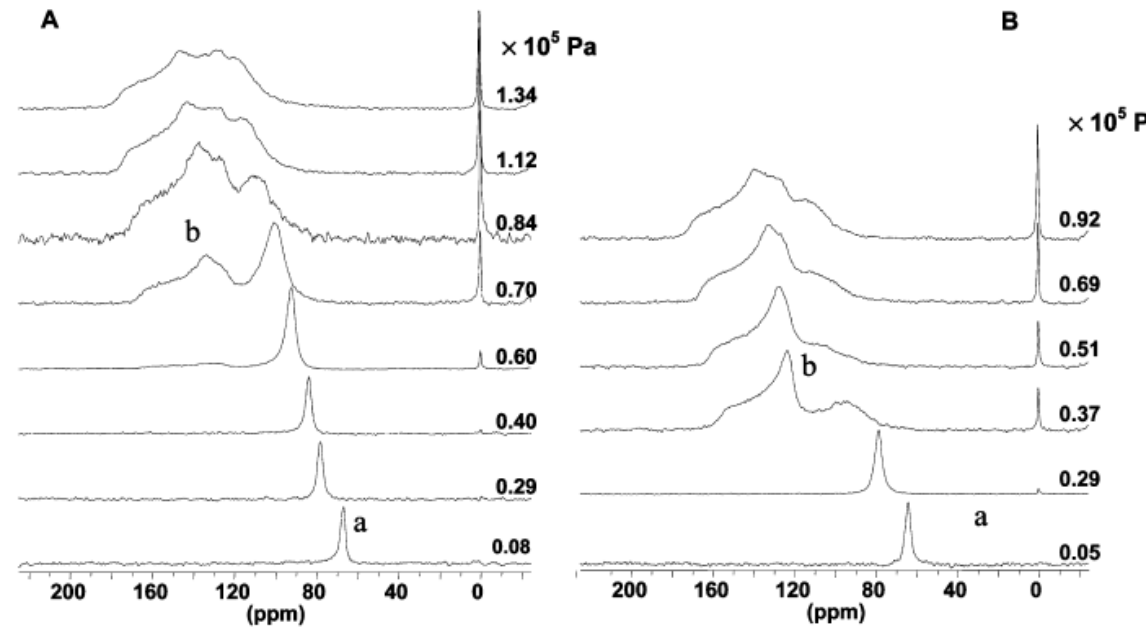
Figure 18. 129 Xe NMR spectra measured under various xenon pressures. ( A ) Adsorption; ( B ) Desorption. Reprinted with permission from [110]. Copyright 2010